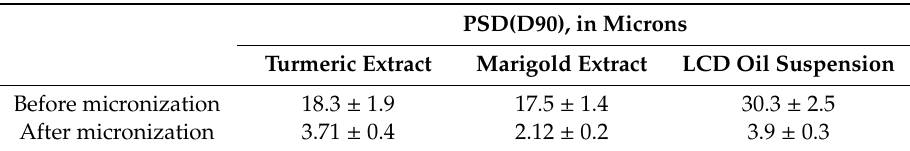
Table 1. Particle size determination of particles.